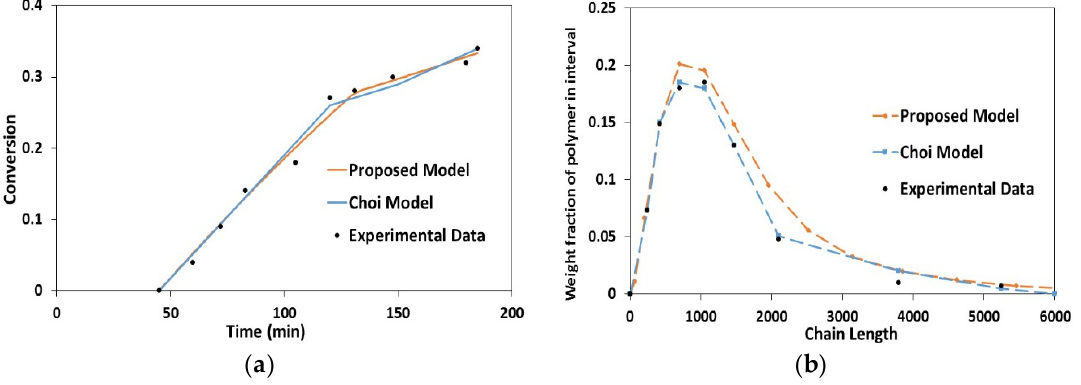
Figure 4. Comparison between model simulations and literature results. ( a ) Panel-Conversion profile. ( b ) Panel-Molar mass distribution at the end of the batch.